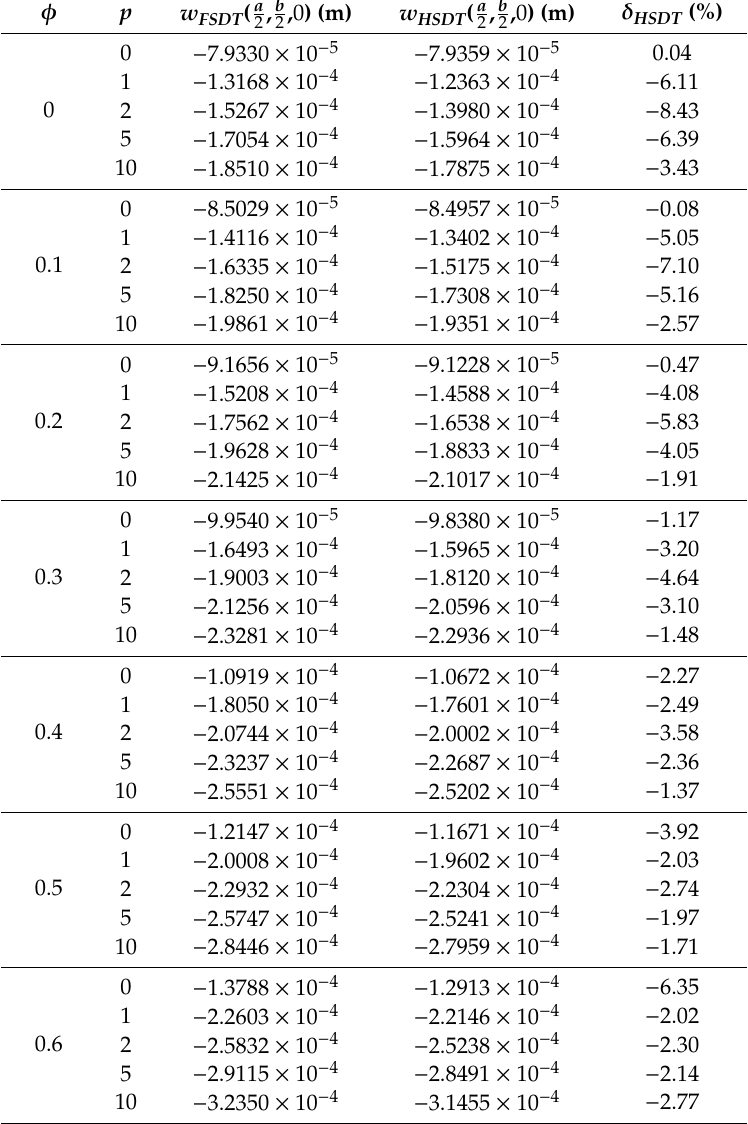
Table 7. Porosity distribution model M1: plate’s center transverse displacement for di ff erent shear deformation